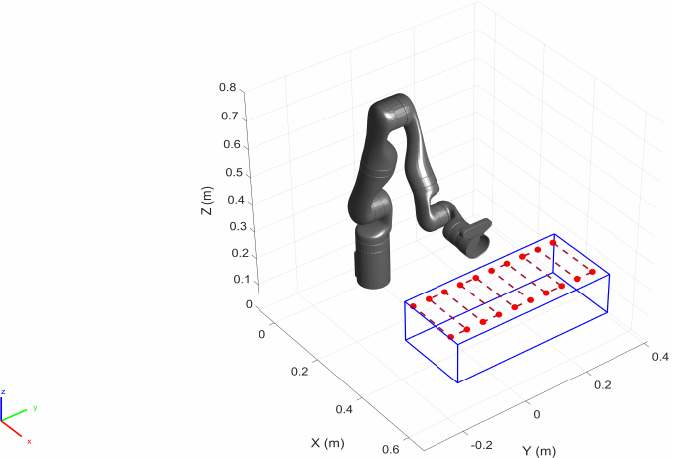
Figure 13. Spatial data points are created within the pre-defined work volume and the test data samples are collected as the robot moves to each of the locations.